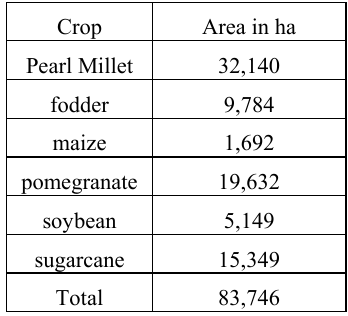
Table 3. Cultivated area of major crops in Kharif